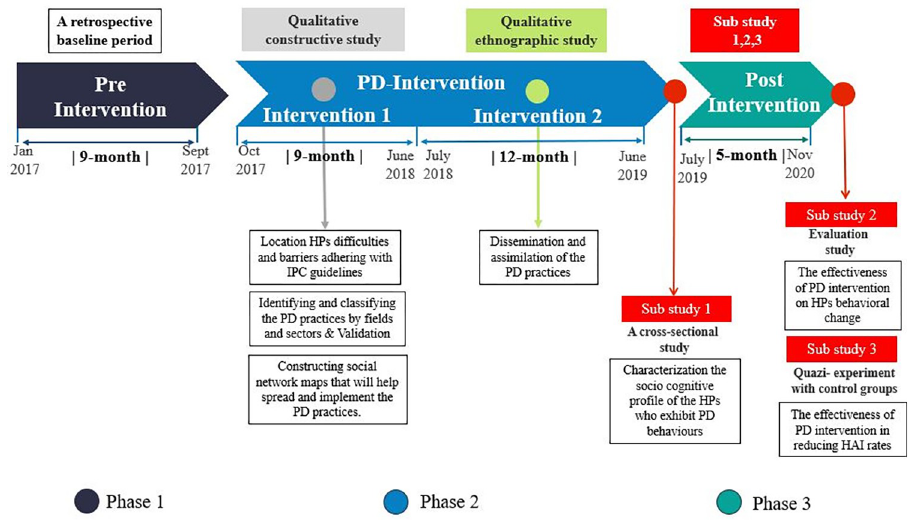
Fig 1. Empirical study design.